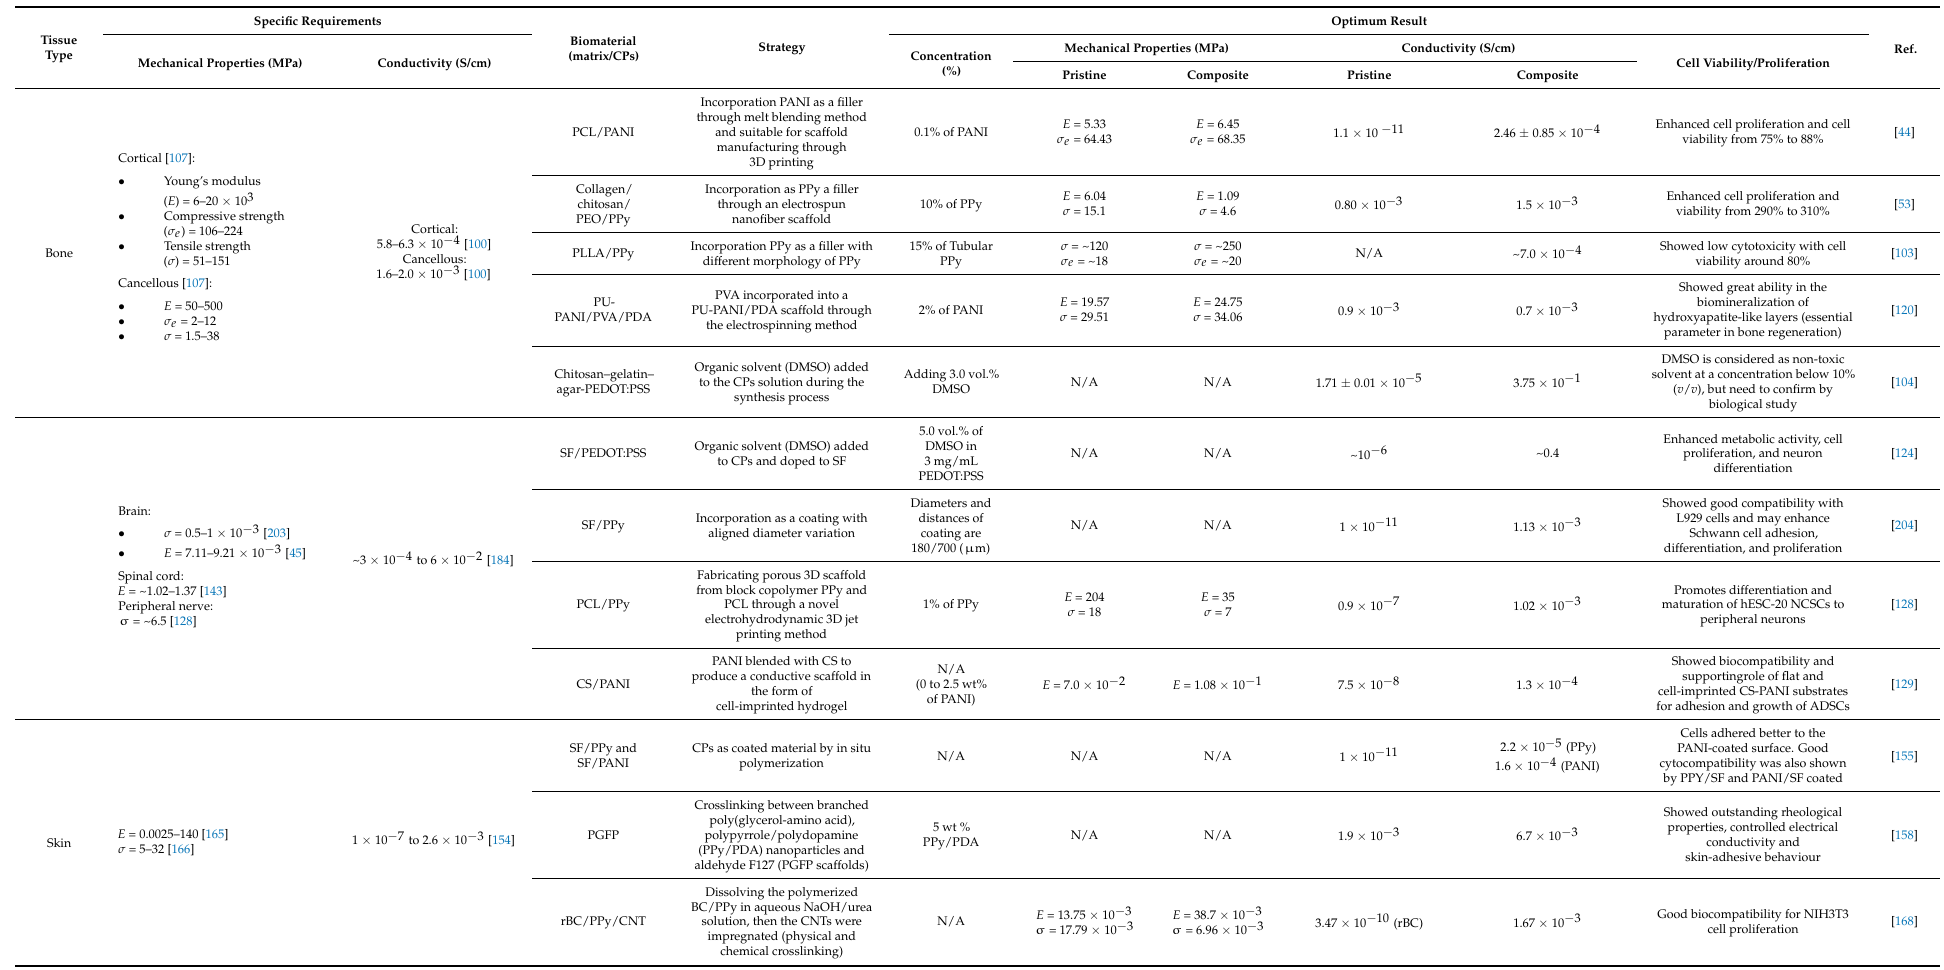
Table 1. Non-exhaustive summary of CP-based scaffolds in various tissue engineering